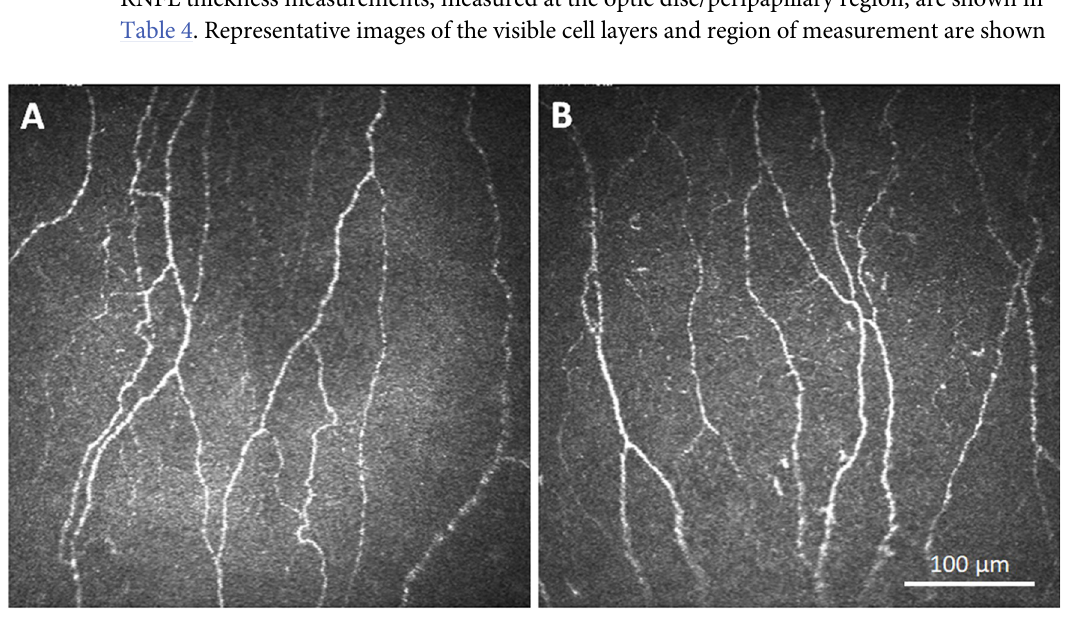
Fig 1. In vivo confocal images of the corneal subbasal nerve plexus (SBNP). (A) Confocal imaging showing a normal distribution of corneal subbasal nerve fibers in a patient with OSA. (B) Confocal image of the corneal subbasal nerve plexus in a non-OSA control patient. Scale bar: 100 μ